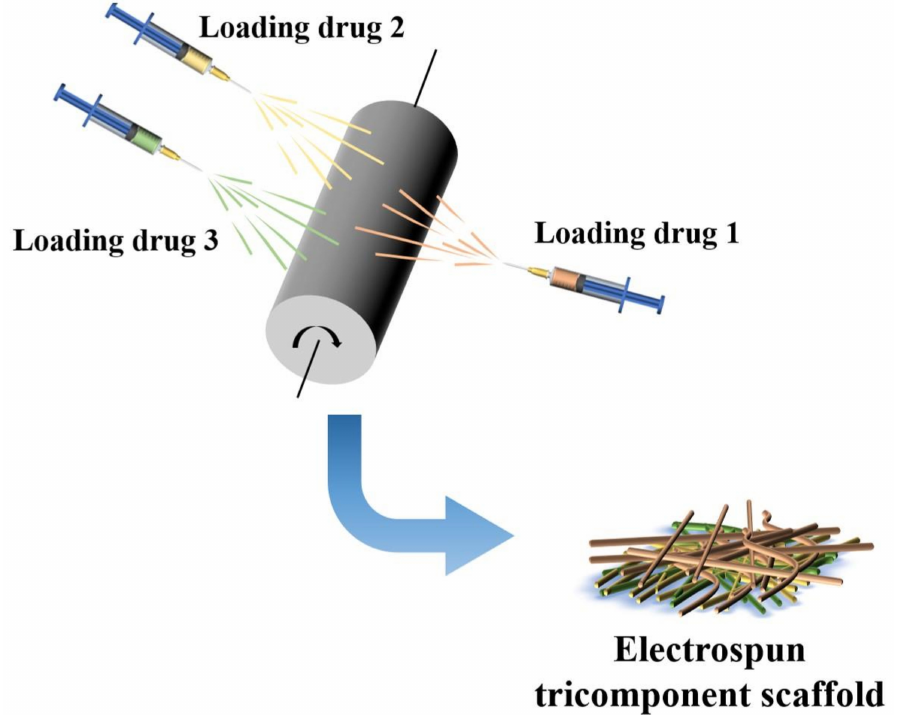
Figure 8. The illustration of a tricomponent delivery scaffold incorporating rhBMP-2, rhVEGF. and calcium phosphate nanoparticles by co-electrospinning. Reproduced with permission [46]. Copyright © 2021, The Royal Society of